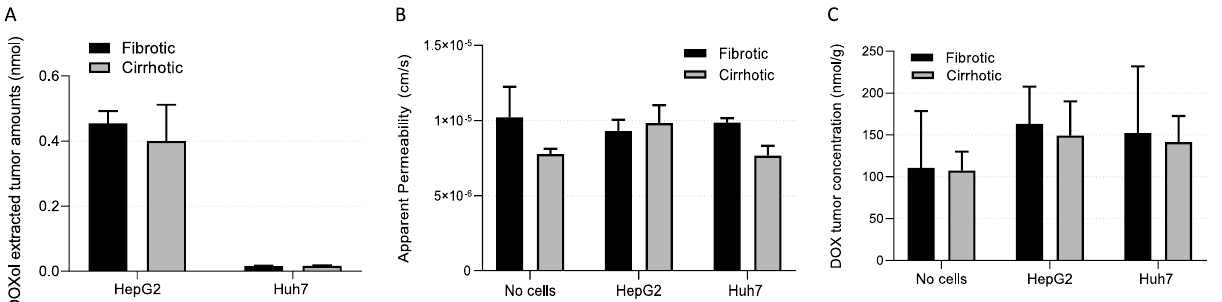
Figure 6. ( A ) Permeability of doxorubicin (1 mM) in fibrotic and cirrhotic gels without cells and with HepG2 or Huh7 cells. Doxorubicinol ( B ) and Doxorubicin ( C ) tumour concentration (nmol/g) in collected fibrotic and cirrhotic gels without cells or with HepG2 or Huh7 cells. (n = 3, error bars =